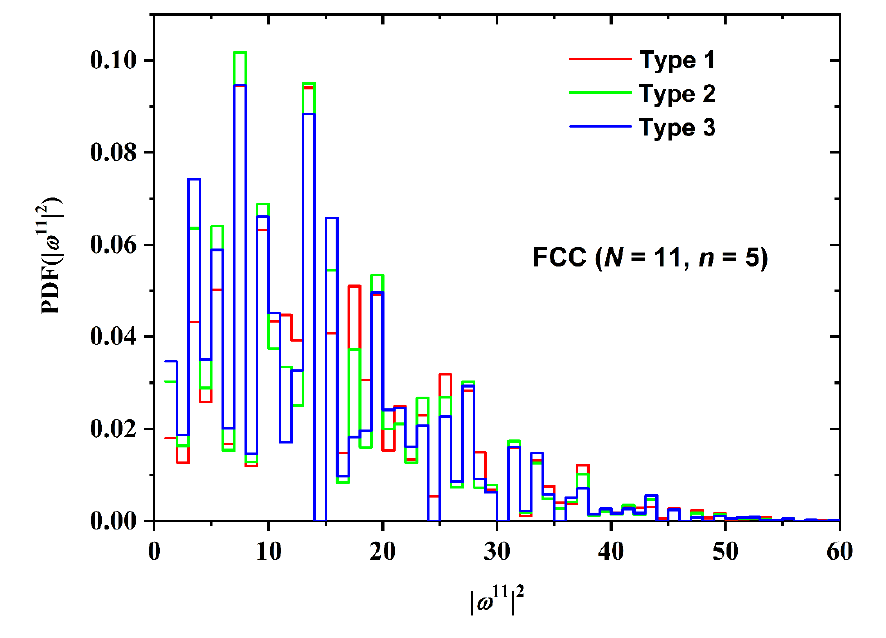
Figure 14. Probability distribution function (PDF) of the square end-to-end distance for the FCC restricted lattice for SAWs of fixed length ( N = 11) and number of layers between confining plates ( n = 5). Different curves correspond to different point of origin (Type). Cumulative distribution functions and the folded variants for SAW size, as quantified by the square end-to-end distance, are presented in Figure 15 (SC lattice with fixed n = 5 , Type 3 and varied N ), Figure 16 (BCC lattice with fixed N = 14, n = 5 and varied Type), and Figure 17 (FCC lattice with fixed N = 11, Type 1 and varied n